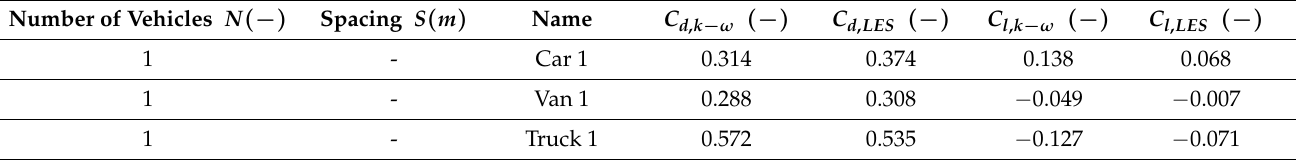
Table 4. Drag coefficient and lift coefficient for a single vehicle.